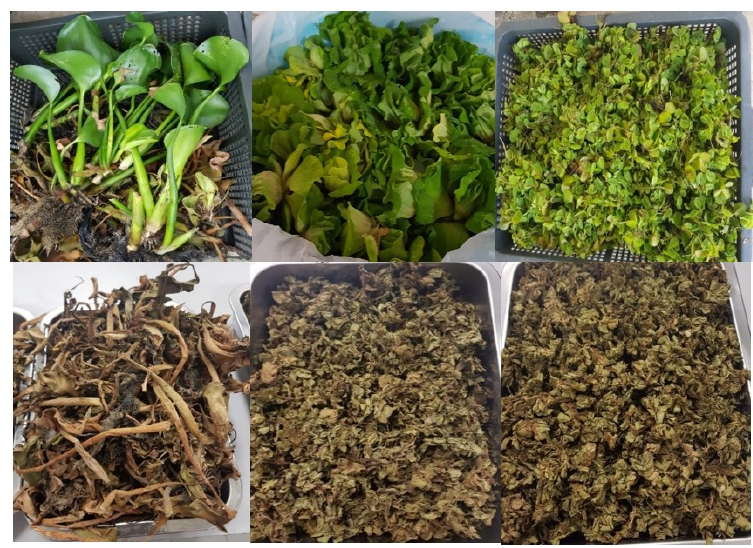
Figure 4. Harvested plant biomass.